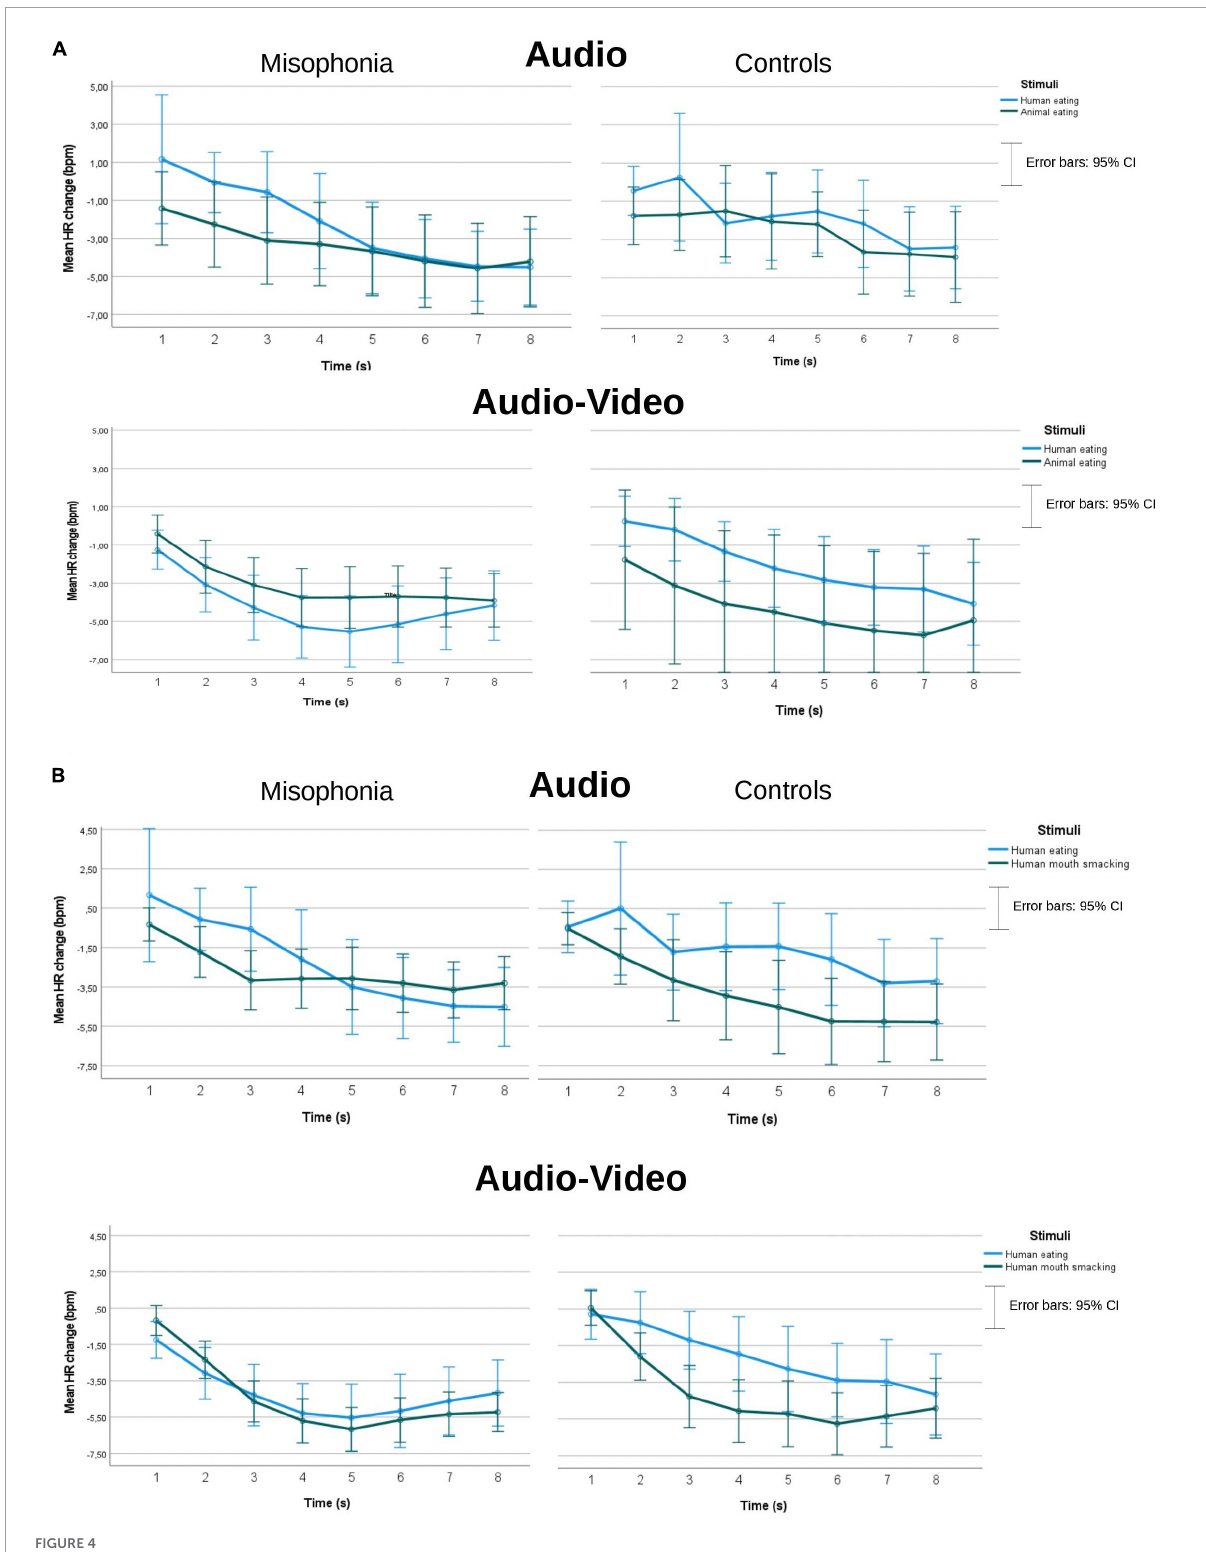
FIGURE4 Mean HR changes (bpm) separately for misophonia and controls and two kinds of presentations (audio and audio-video), and for two separate analyses (A,B)